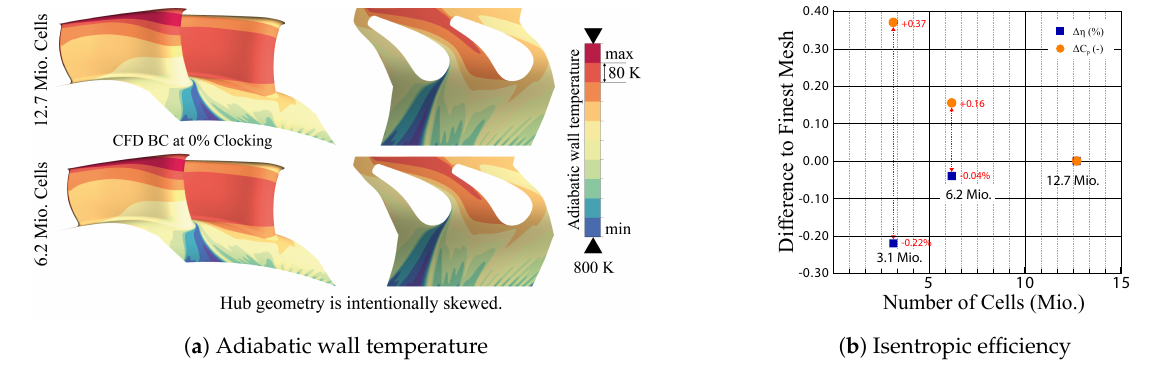
Figure 10. Results of the mesh refinement study. Mio: million, BC: boundary condition.